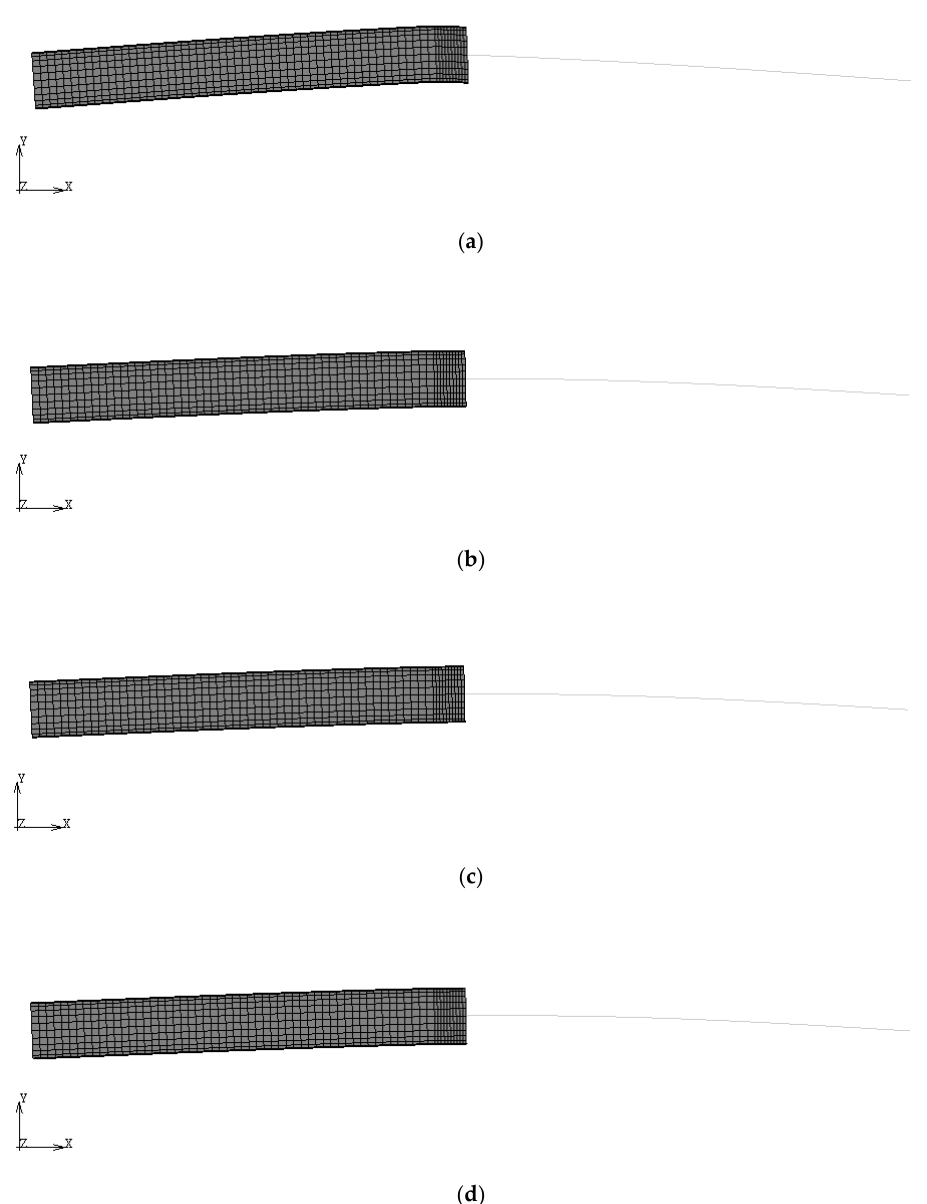
Figure 7. Local buckling deformation of the composite cylinder tube for the test cases named: ( a ) A, ( b ) B, ( c ) C, and ( d ) D (magnitude factor x 5000).